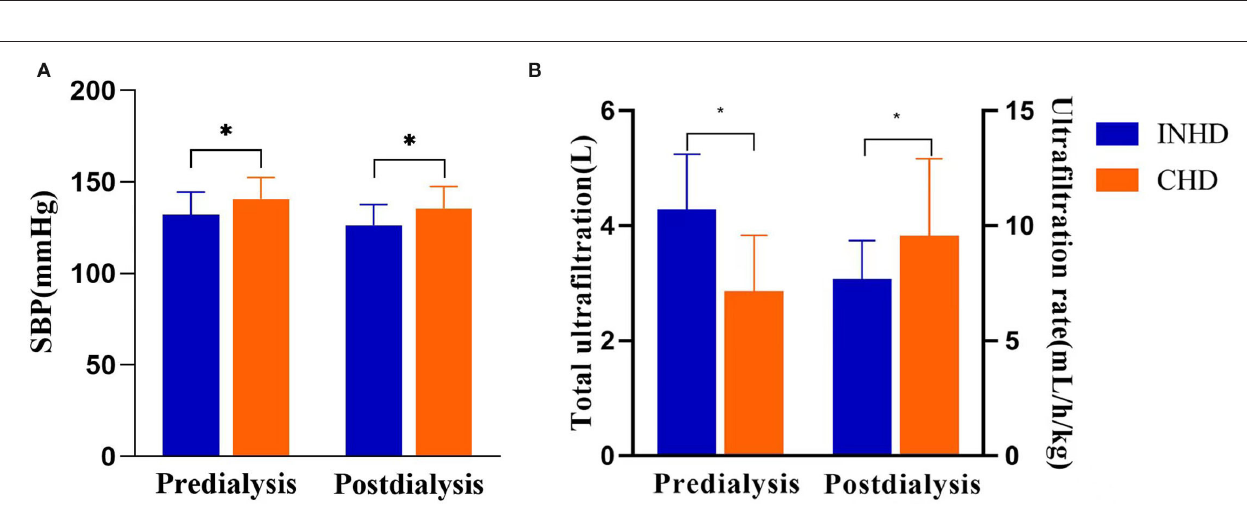
categories of drugs between the two groups, but the dosage of calcium-containing phosphate binders was significantly